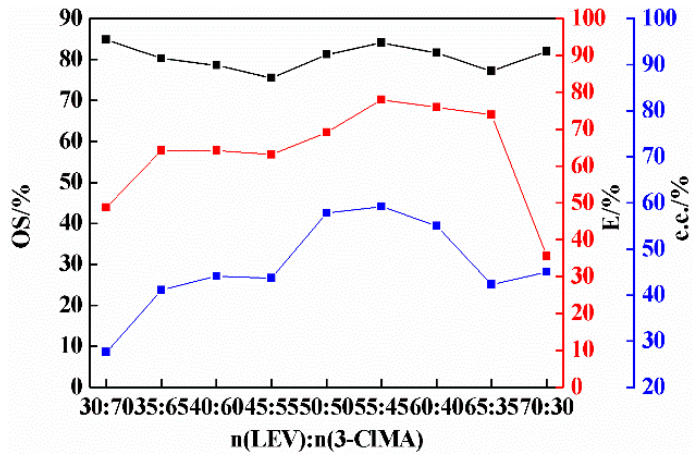
Figure 3. Effect of molar ratio on resolution of 3-ClMA by LEV (3-ClMA = 2.58 mmol; acetonitrile = 1.5 mL; crystallization temperature = − 15 ◦ C; equilibrium time = 12 days).